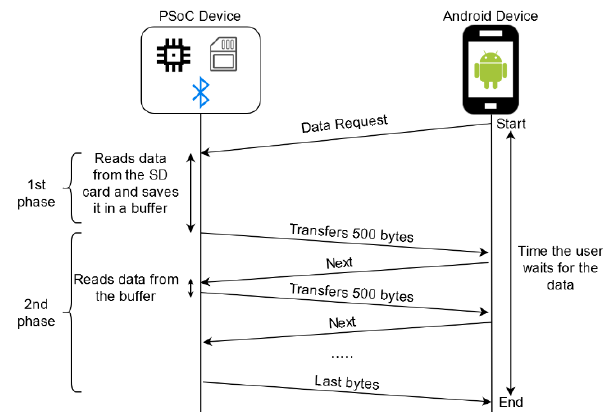
Figure 12. Test setup for measurement of the total